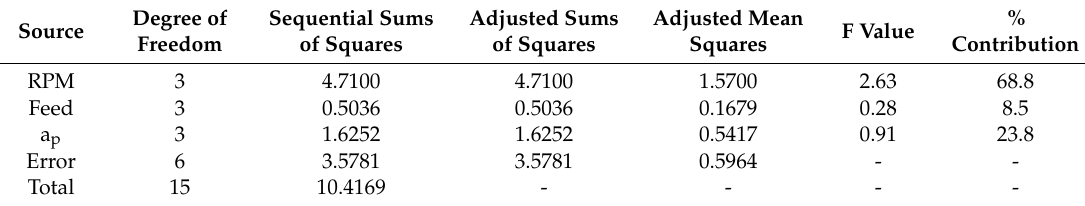
Figure 4. Interaction plot for surface roughness (RA). Table 5. Analysis of Variance for Surface Roughness (RA).